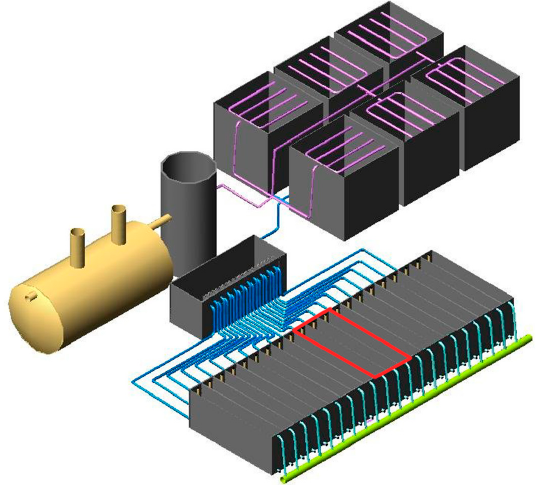
Figure A1. System scheme modified from Nurk et al. [30]. Horizontal subsurface flow constructed wetland (HSSF CW) mesocosms used in this study are marked with red colour.